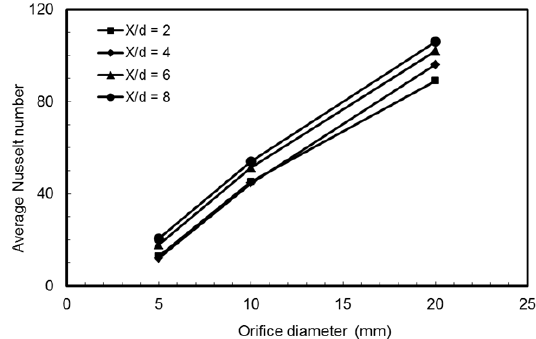
Figure 11. VariationofaverageNusseltnumberwithorificediameter at different distances from the orifice (jet velocity = 30